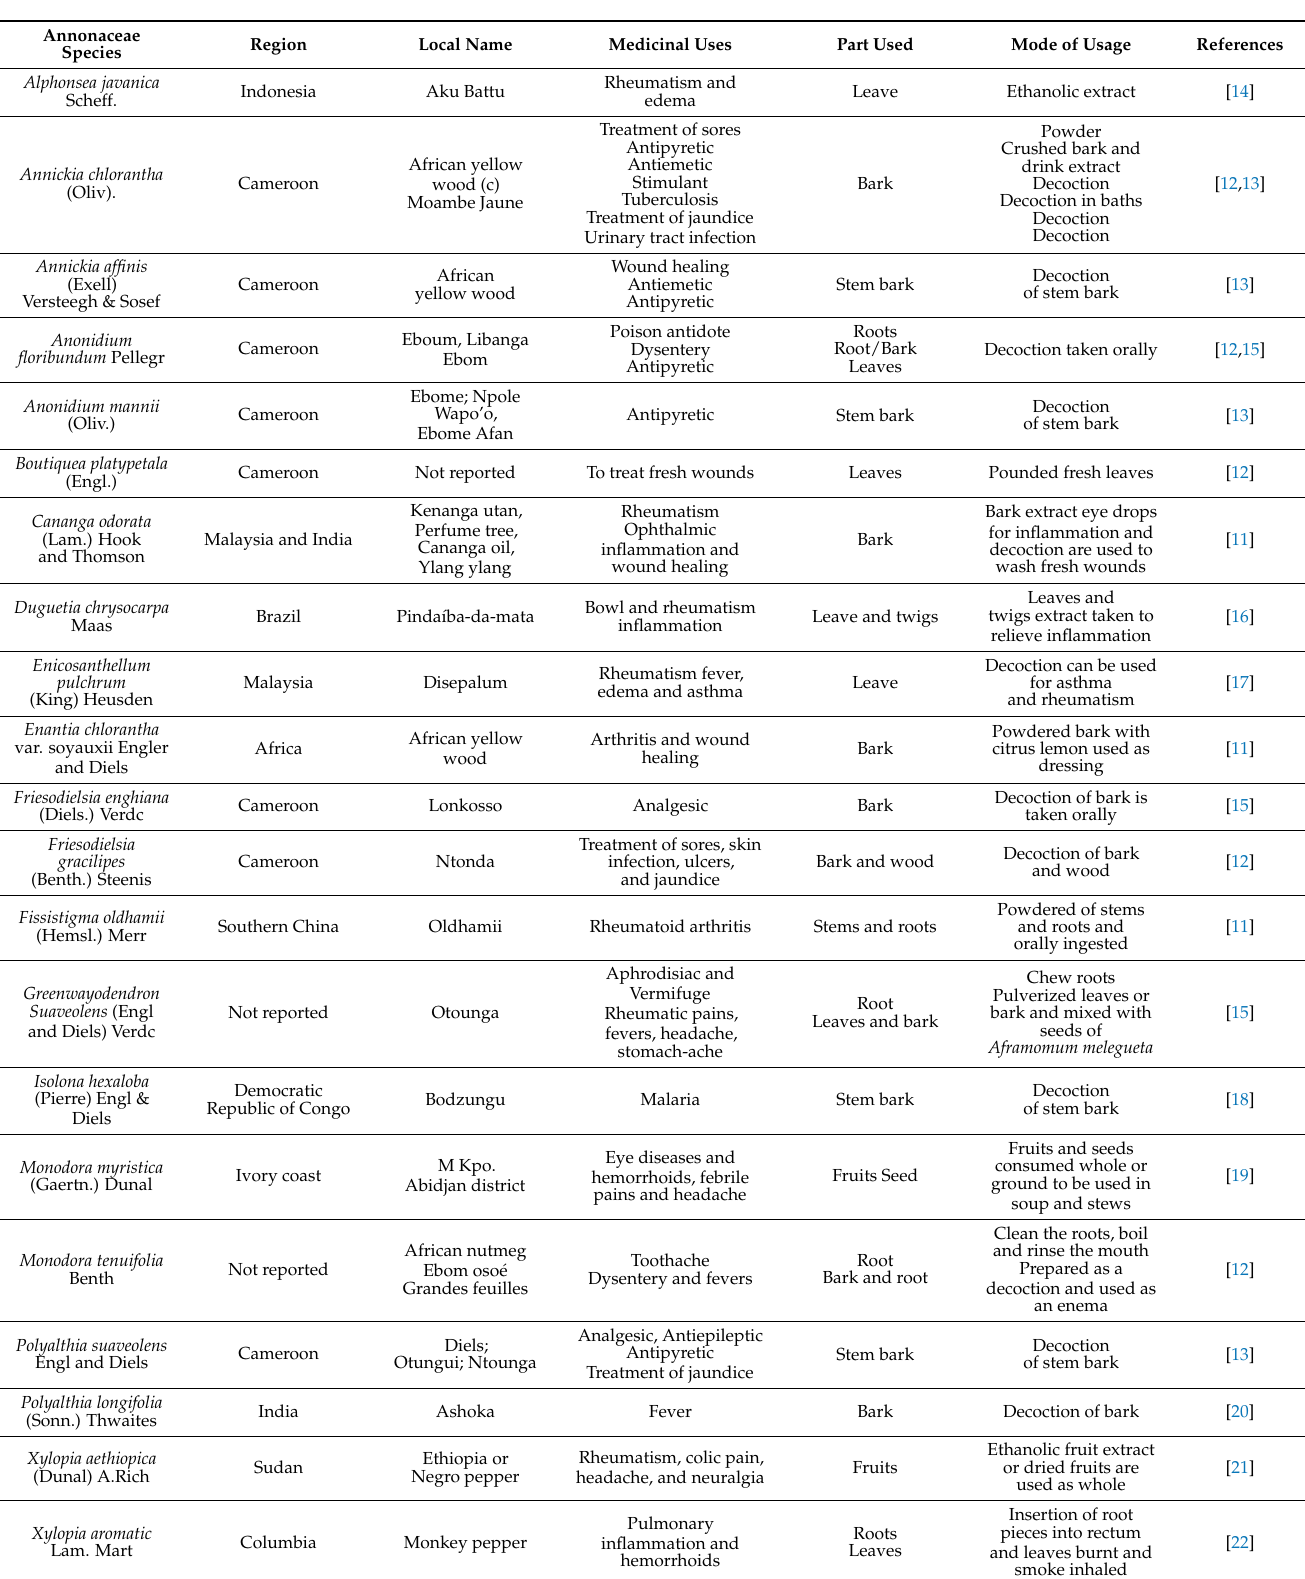
Table 1. Uses of most commonly used Annonaceae family in traditional